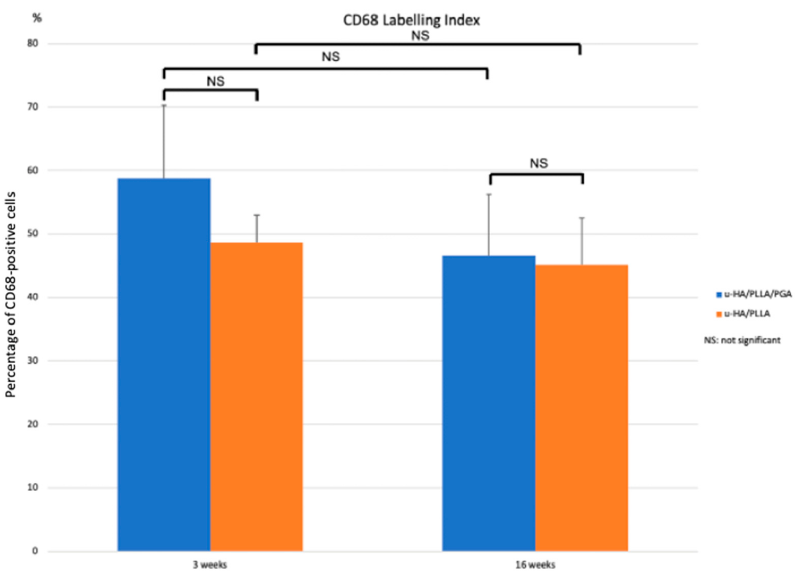
Figure 15. Labeling index based on IHC staining using an anti-CD68 antibody in the u- HA/PLLA/PGA and u-HA/PLLA subgroups.